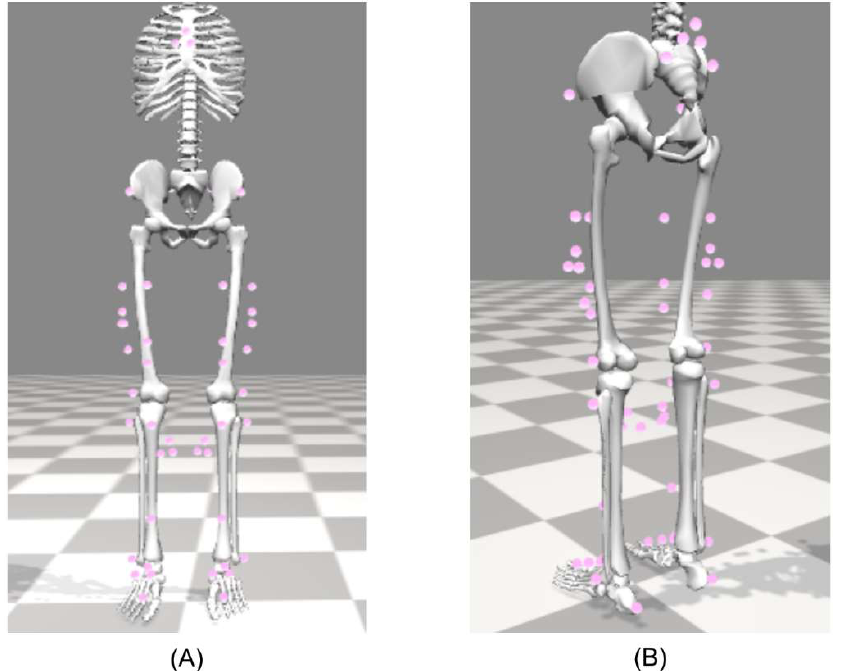
Figure 4. Marker locations (pink dots) used for MOCAP comparisons, visualized using OpenSim. ( A ) Front and ( B ) back views.